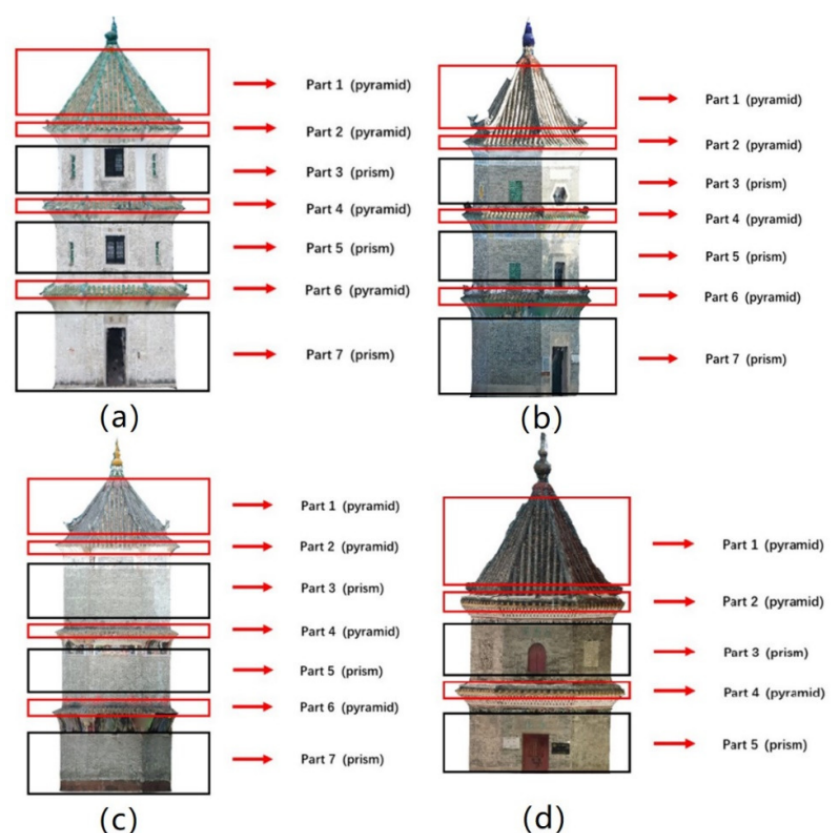
Figure 8. Pagoda point clouds divided into different parts for the proposed model: ( a ) Pagoda A; ( b ) Pagoda B; ( c ) Pagoda C; and ( d ) Pagoda